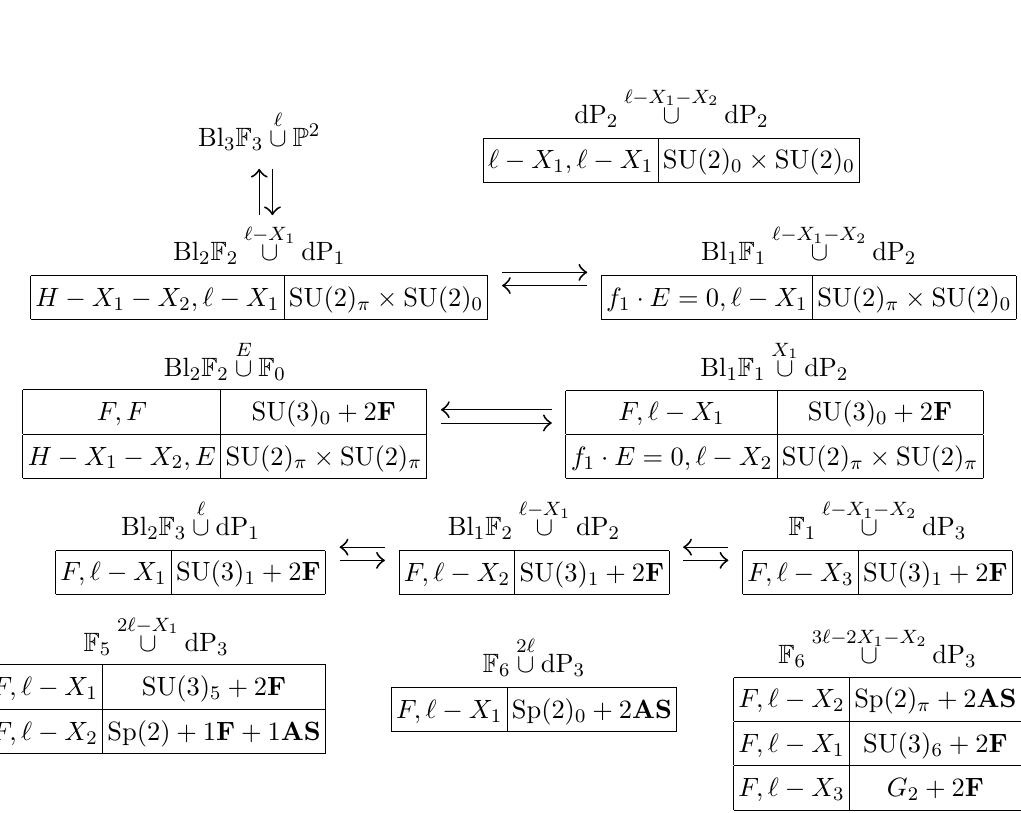
Figure 24. M = 3 geometries, cont. Note that for the geometry dP 2 curves in both surfaces are C = ‘